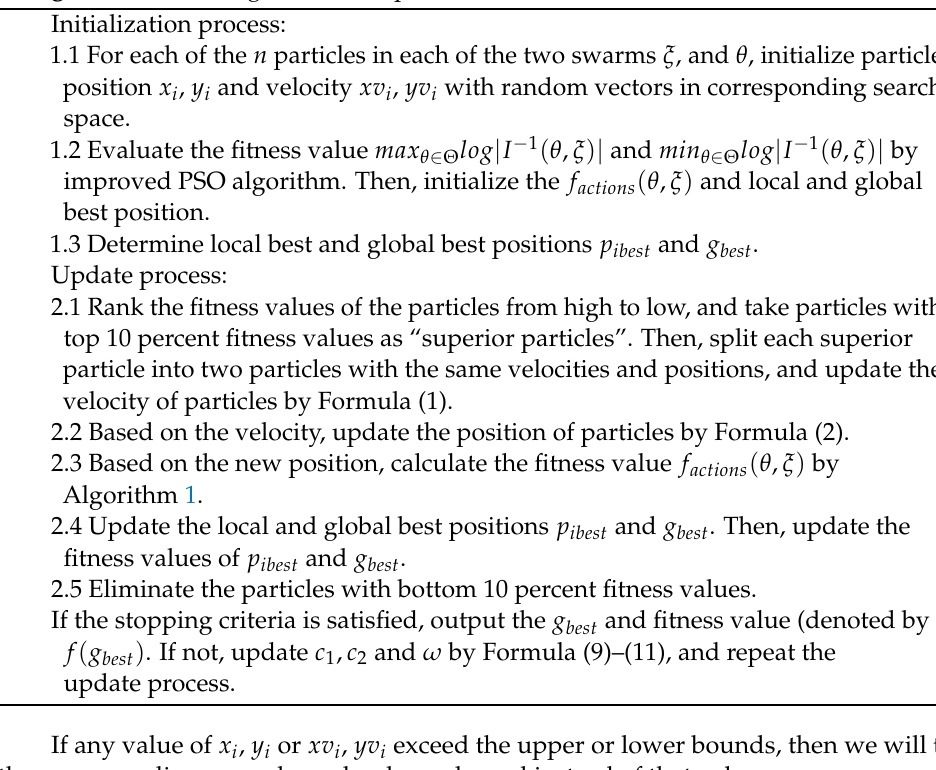
Algorithm 2: PSO algorithm for optimistic coefficient